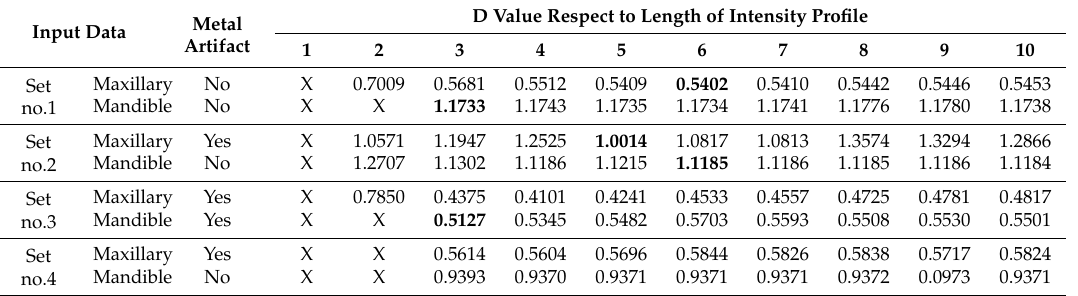
Table 3. Modified iterative closest point (MICP) results with different length values for the intensity profiles.